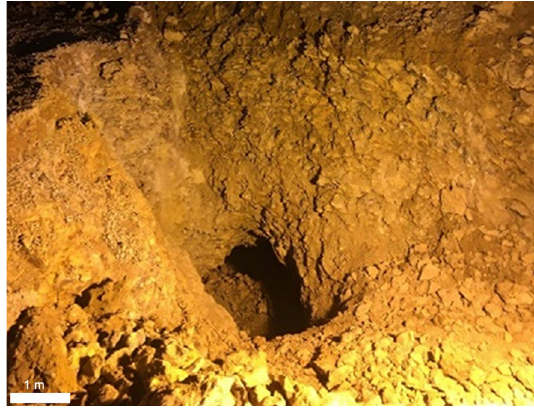
Fig. 7 Karst cave encountered during tunnel excavation in dolomitic limestones